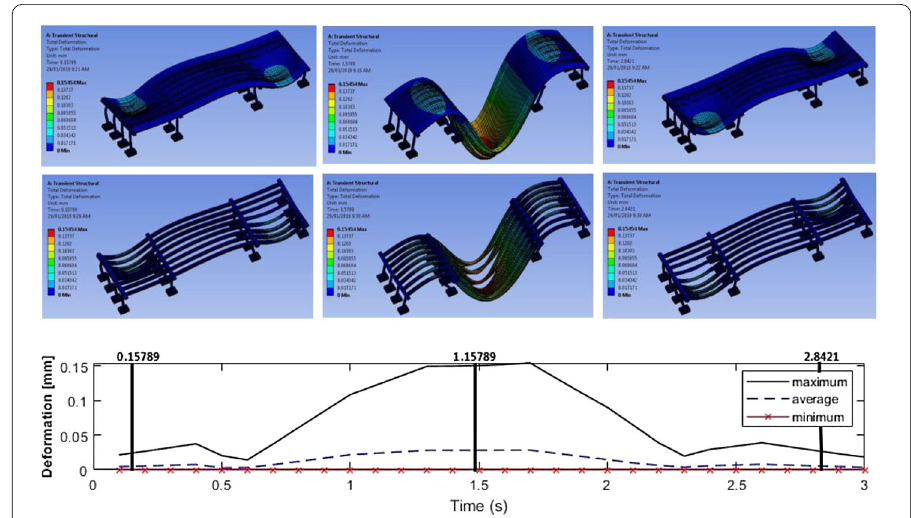
Figure 5 Total deformation of the bridge structure with half beam–beam shaped connection. Magnitude of bridge deformation at three instants of time 0.5789 s, 1.5789 s, and 2.8421 s: maximum (top line), average (middle line) and minimum (bottom line)